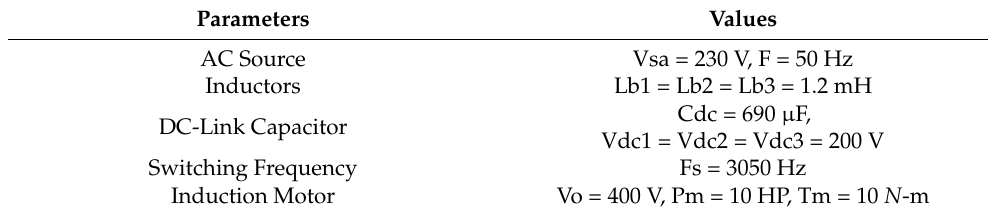
Table 3. System specifications.